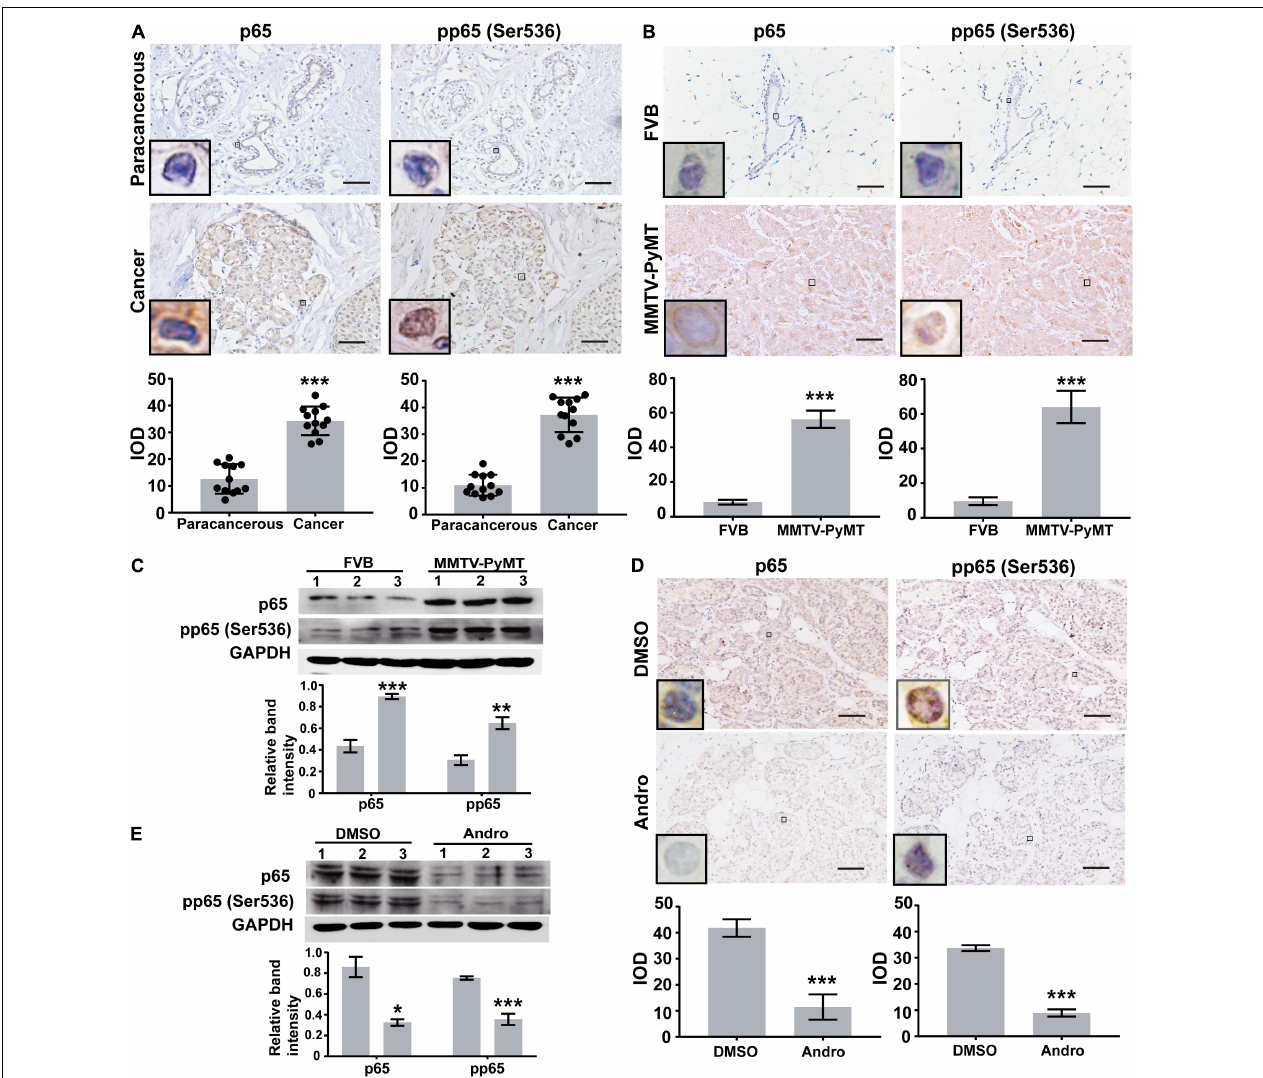
FIGURE 1 | Expression levels of NF- κ B. Immunohistochemistry (IHC) assay analysis the expression levels of p65 and pp65(Ser536) in (A) human luminal-like breast cancer tissues and the matched surrounding non-cancerous breast tissues (paracancerous, n = 12) and (B) tumor tissues of spontaneous luminal-like breast cancer mice (MMTV-PyMT) and breast tissues of matched background mice (FVB, n = 3). (C) Immunoblotting analysis in mice breast tissue lysates. (D) Expressions of p65 and pp65 (Ser536) in the tumor tissues of dimethyl sulfoxide (DMSO)- or andrographolide (Andro)-treated MMTV-PyMT mice ( n = 3). (E) Immunoblotting analysis of p65 and pp65 (Ser536) expression in MCF-7 cells. Quantitative data are expressed as the mean ± SD. Significant effect: ** P < 0.01; *** P < 0.001. Scale bar , 50 µ M.